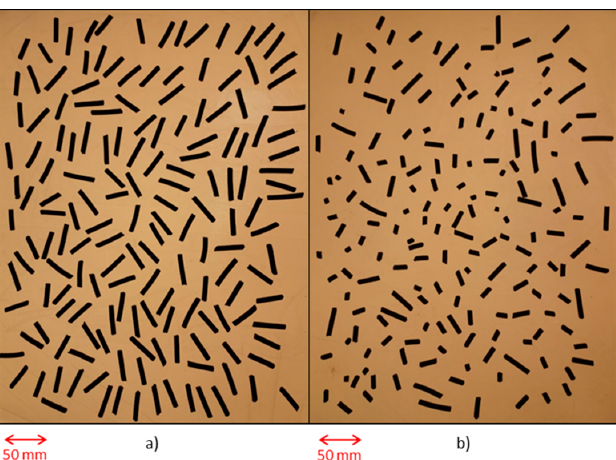
Figure 4. A sample image taken from the torrefied mixed wood pellets, ( a ) before and ( b ) after mechanical durability test.